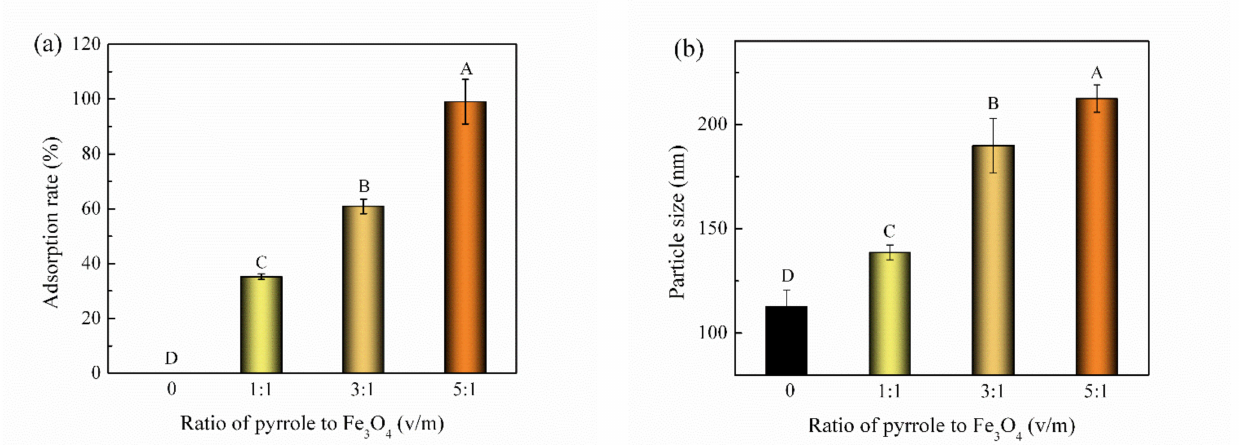
Figure 1. Effect of the ratio of pyrrole to Fe 3 O 4 on the adsorption rate for VD 3 . ( a ) Adsorption rate and ( b ) particle size of Fe 3 O 4 @PPy composites. Fe 3 O 4 NPs were used for comparison (ratio of 0). Data is expressed as the mean ± standard deviation ( n = 3). The different capital letters (A–D) indicate a significant difference ( p <